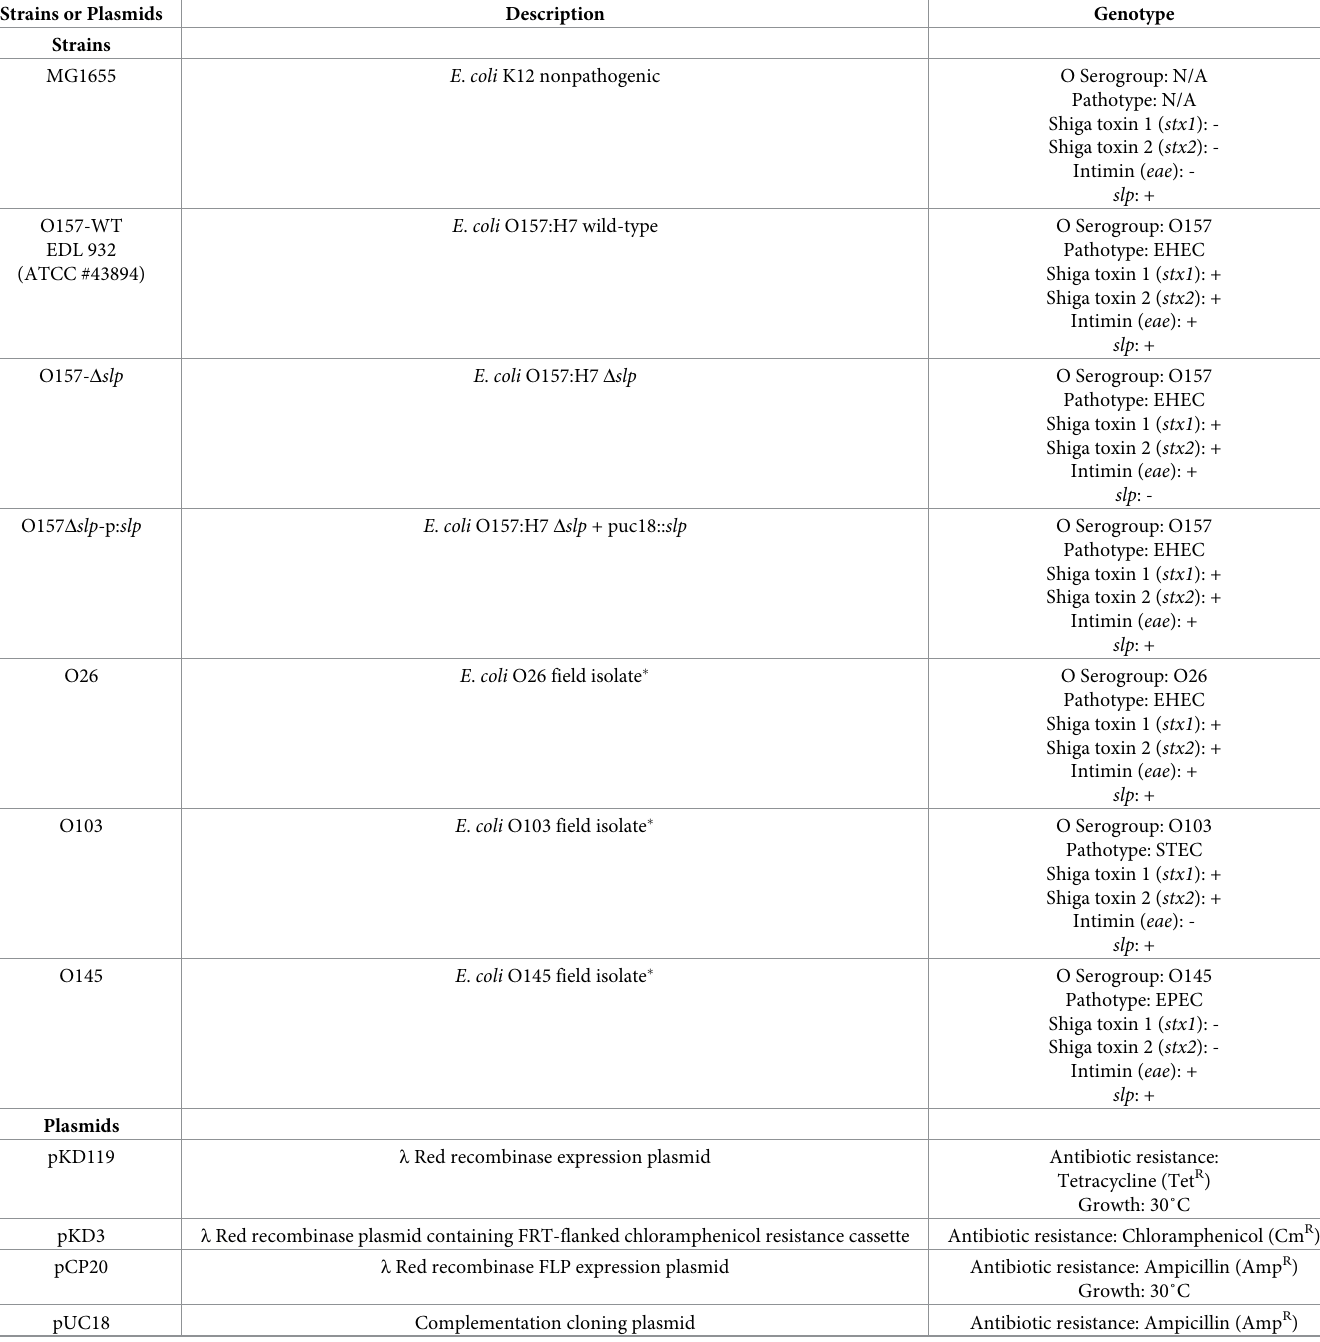
Table 1. Bacterial strains and